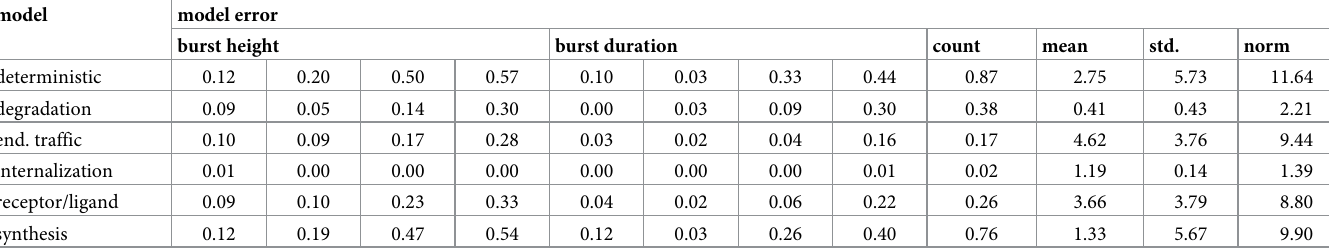
Table 1. Goodness-of-fit of stochastic block models with respect to components of the objective function.